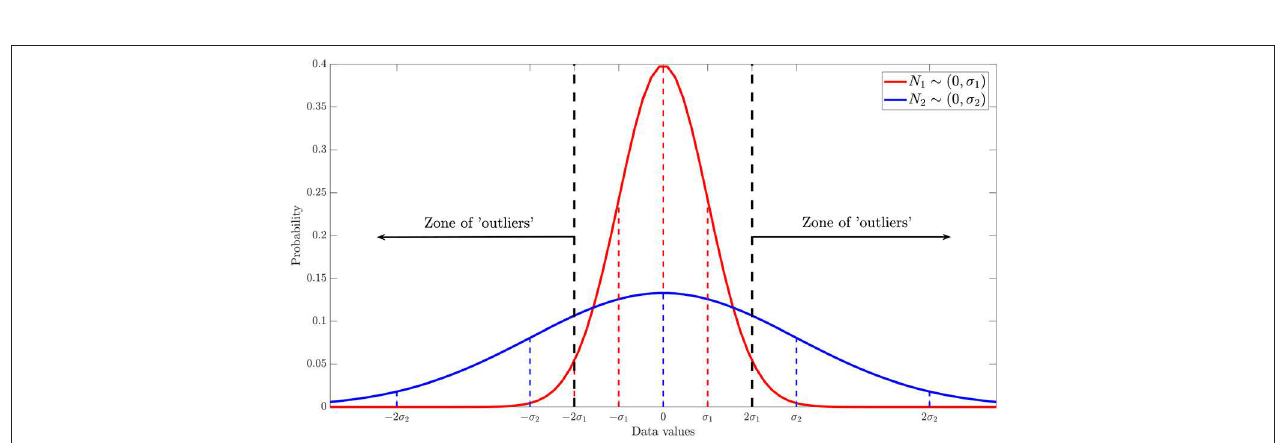
FIGURE 9 | Scheme of the non-arbitrary and statistical methodology proposed to generate outliers, given a known dataset with random error.